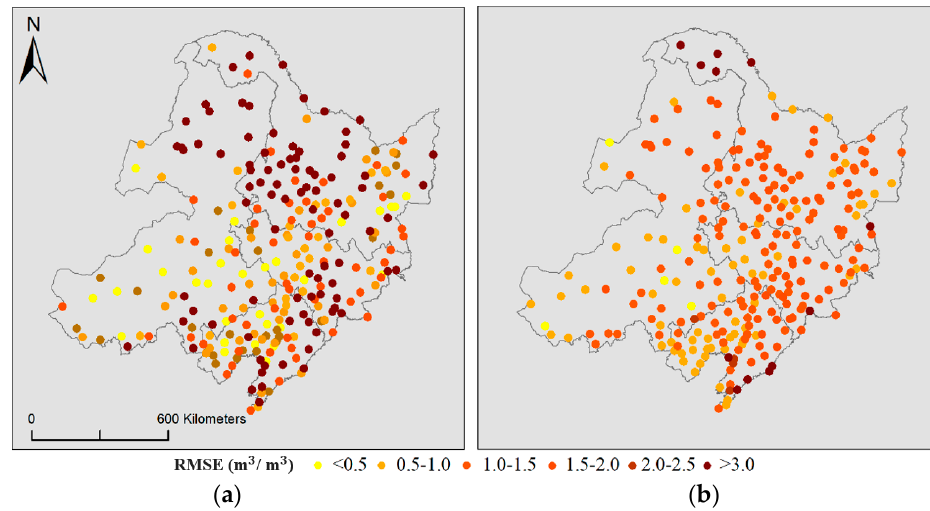
Figure 3. Downscaled soil moisture (SM) (1-km scale) based on the spatial fusion downscaling model (SFDM) versus the in situ SM: ( a ) daytime; ( b ) nighttime. The solid line is the trend line.